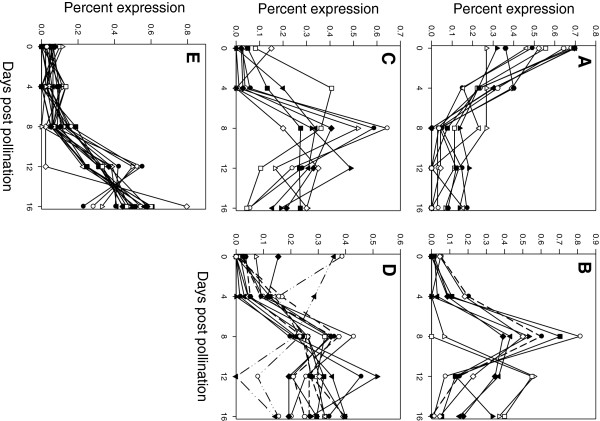
Functional groups of genes showing age-specific expression. (A) Expression of cyclin related genes relative to fruit age plotted as percent total expression for that transcript observed at each age [putative homologs of cyclins B1;2 (At5g06150), B1;4 (At2g26760); D1;1 (At1g70210);, D3;1 (At4g34160), D3;3 (At3g50070), D5;1 (At4g37630), and cyclin dependent kinases (CDK), CDKB1;2 (At2g38620), CDKB2;2 (At1g20930), CDKD1;3 (At1g18040), CDKE;1 (At5g63610); CKS1 (At2g27960)]. (B) GDSL-motif lipase/hydrolase family protein genes (putative homologs of At1g09390, At1g56670, At2g04570, At2g42990, At3g16370, At3g48460, At5g03610, At5g14450, At5g33370, At5g62930) and transcription factor SHINE1 (At 1 g15360; dotted line). (C,) Lipid transfer protein (LTP) family protein genes (putative homologs of At1g48750, At1g62510, At2g10940, At2g45180, At5g01870, At5g64080). (D) Phloem proteins. Solid lines indicate cucurbit specific phloem proteins as listed in Table 1. Dotted lines indicate putative homologs to Arabidopsis phloem proteins (ATPP) 2-A genes (two for ATPP2-A1, one for ATPP2-A9, and ATPP2-A13); dashed lines are putative homologs of ATPP2-B genes (ATPP-B10 and ATPP-B12). (E) Transcription factors showing preferential expression at 12 +16 dpp (putative homologs of At1g27730, At1g50640, At2g17040, At2g26150, At2g40140, 2 g46240, At3g15210, At3g15510, At3g16770, AT3g56400, At4g11660, At4g16780, At4g39250, At5g25560, At5g51190)